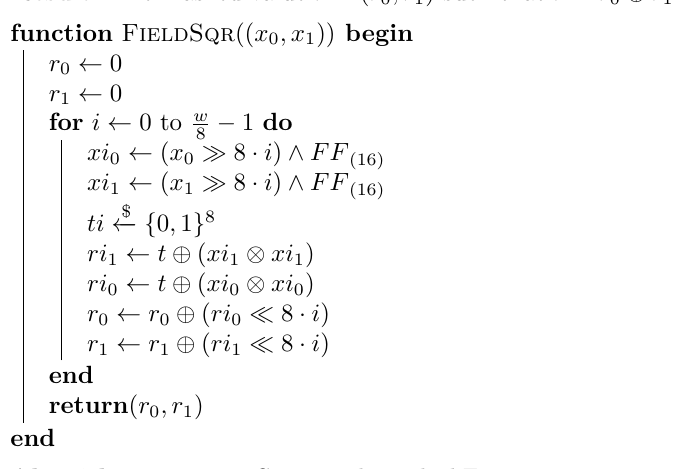
Algorithm 20: FieldSqr : apply packed F